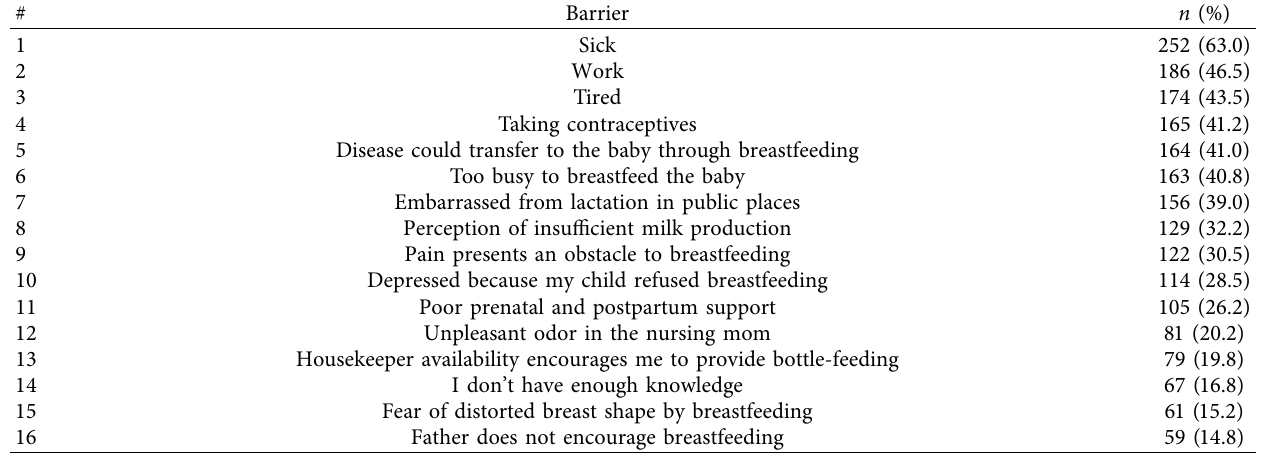
Table 3: Distribution of the study group by barriers to breastfeeding ( n � 400).